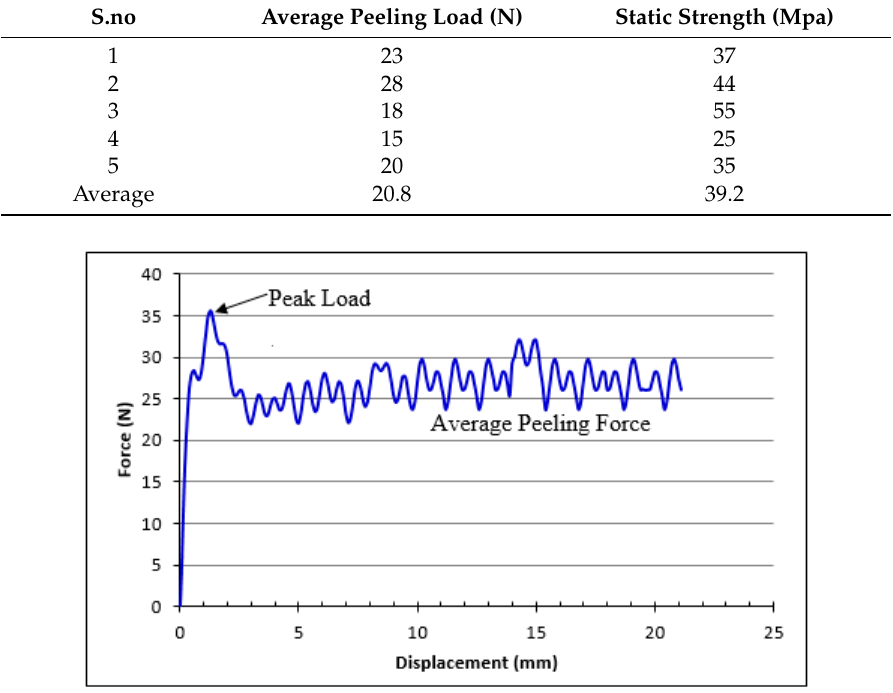
Figure 20. Typical load-displacement plot achieved from T-peel tests of CFC-aluminum bond.